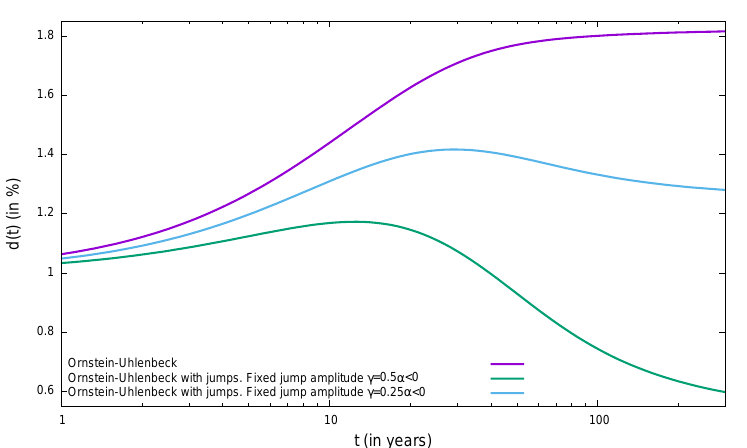
Figure 1. The discount rate (54) (in %) as a function of time (in years). We present the effects of the addition of jumps to the Ornstein–Uhlenbeck process by modifying the scaled jump size | γ | / α < 0. Jumps frequency λ is 1/50 years. General parameters for the Ornstein–Uhlenbeck process are those estimated by Ref. [17] for the case of the United States of America, whose estimated parameters are ˆ m = 0.0319 year − 1 , ˆ α = 0.0603 year − 1 , ˆ k 2 = 10.03 × 10 − 5 year − 3